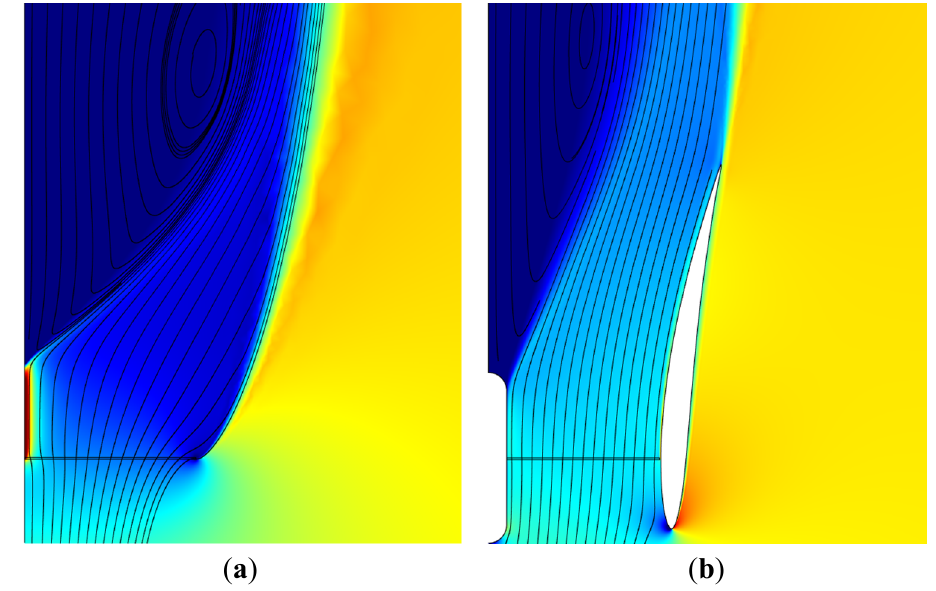
Figure 14. ( a ) HAWT example of inner wake stall (sometimes termed “vortex breakdown”) at (cid:1829) (cid:3404) 1.17 ; ( b ) DAWT example of centerbody stall at (cid:1829) (cid:2904)